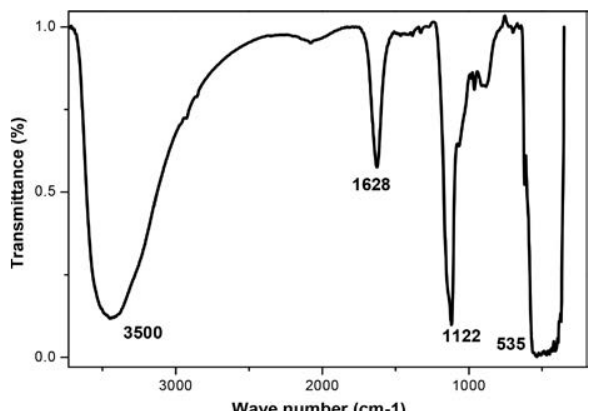
Figure 5. FTIR spectrum of ZnO nanoparticles.